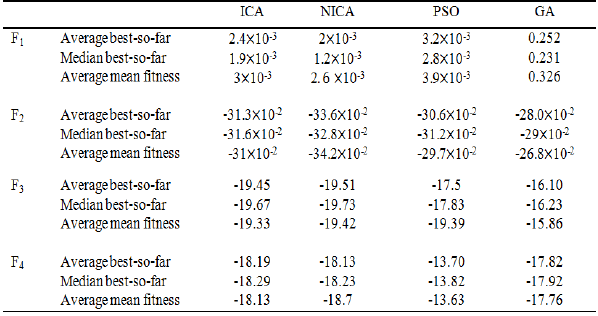
Table 3. Minimization result of benchmark functions in Table